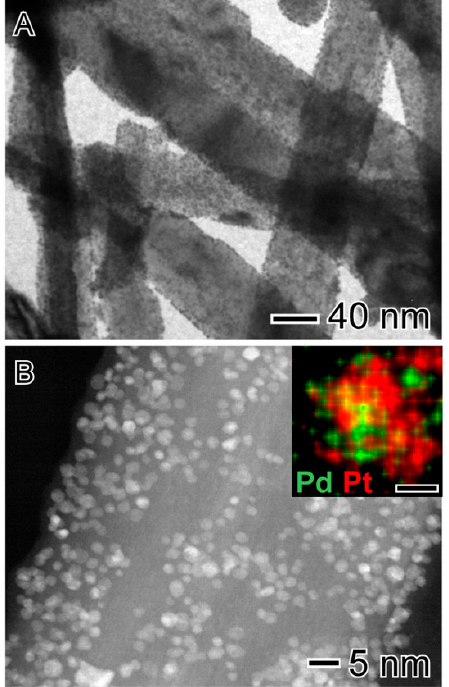
Figure 4. TEM ( A ) and STEM high-angle annular dark field (HAADF) ( B ) images of TiO 2 nanowires decorated with ultra-small bimetallic PtPd NPs. The image inset in B shows a STEM-EDX elemental map for a single PtPd nanoparticle at the surface of TiO 2 nanowires.